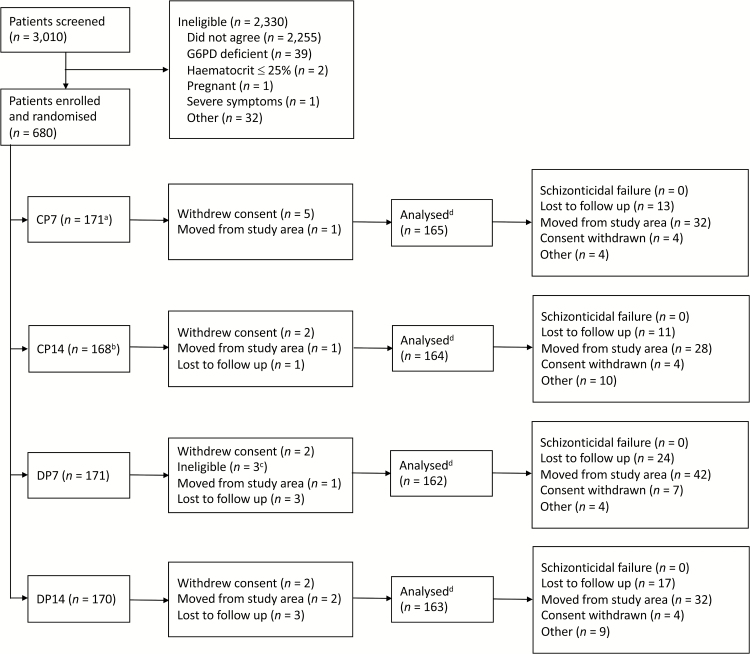
Study diagram. aOne patient randomized to the CP7 arm was given DP7 bTwo patients randomized to the CP14 arm were given CP7 cTwo patients vomited the drug treatment twice and one patient had received a blood transfusion in the prior 3 months. dA total of 26 patient were excluded from the analyses because they had not completed the schizonticidal treatment. The three patients with incorrect randomization were included in the analysis. Abbreviations: CP7, Chloroquine + Primaquine 1 mg/kg/day for 7 days; CP14, Chloroquine + Primaquine 0.5 mg/kg/day for 14 days; DP7, Dihydroartemisinin-piperaquine + Primaquine 1 mg/kg/day for 7 days; DP14, Dihydroartemisinin-piperaquine + Primaquine 0.5 mg/kg/day for 14 days; G6PD, glucose-6-phosphate dehydrogenase.